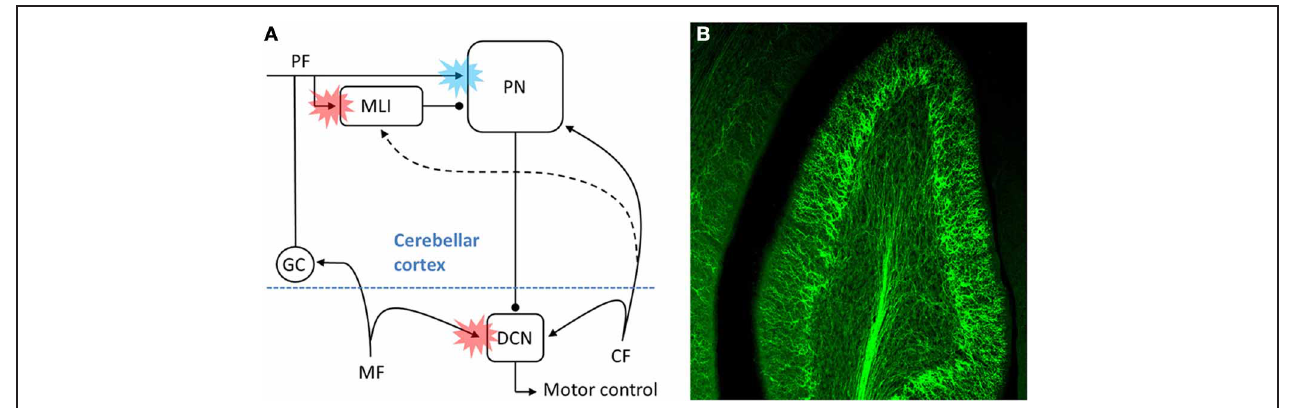
FIGURE 1 | The CF pathway and associative motor learning. (A) Schematic of the proposed sites (colored bursts) within the cerebellar circuit where CFs might teach during associative motor learning. The blue burst denotes CF driven LTD of PFs, while the red bursts denote CF-driven LTP of either PF inputs (at MLI) or inputs MF (at DCN). As discussed in the